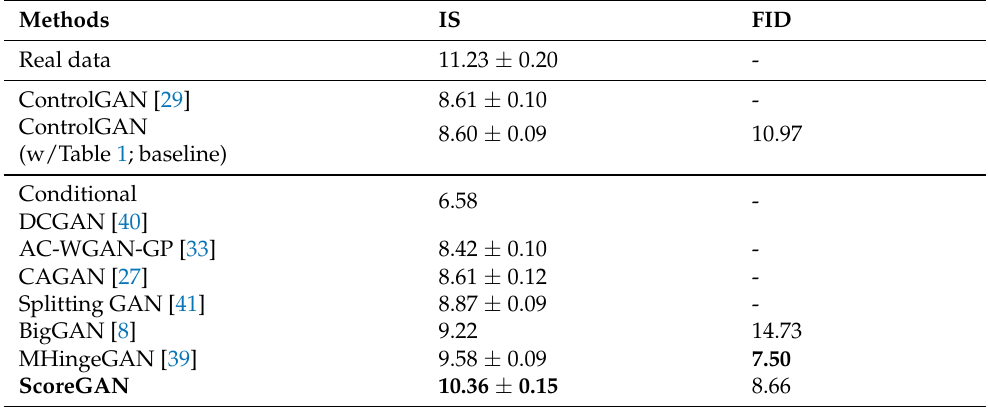
Table 3. Performance of GAN models over the CIFAR-10 dataset. IS indicates the Inception score; FID indicates the Fréchet Inception distance. The best performances are highlighted in bold.